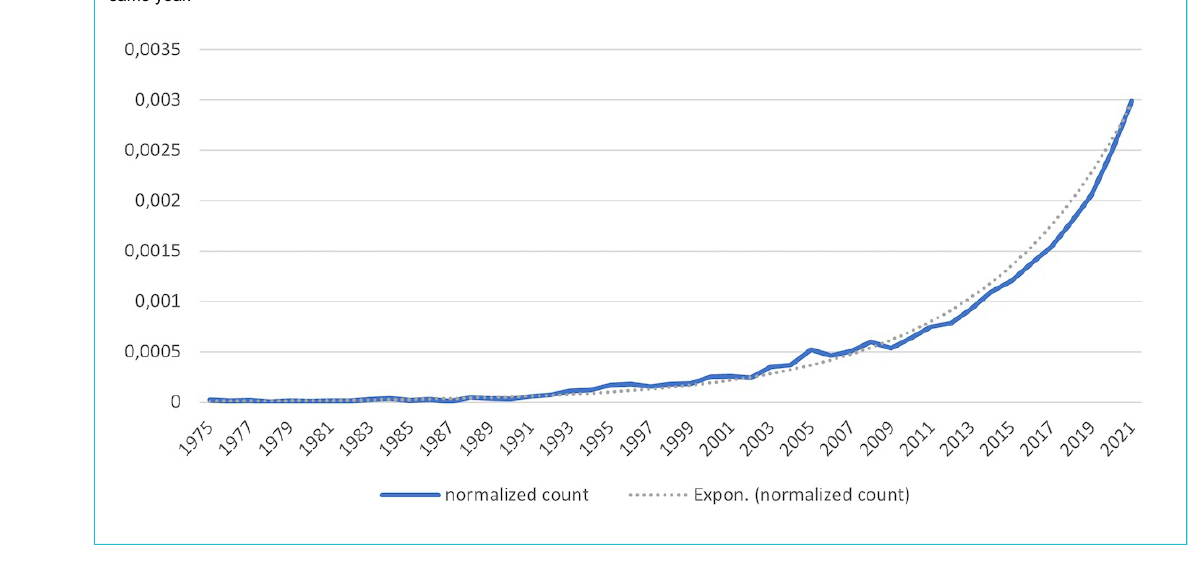
Figure 1: Number of articles captured by our query on “patient narratives”, 1975–2021, normalised to total articles indexed in PubMed in the same